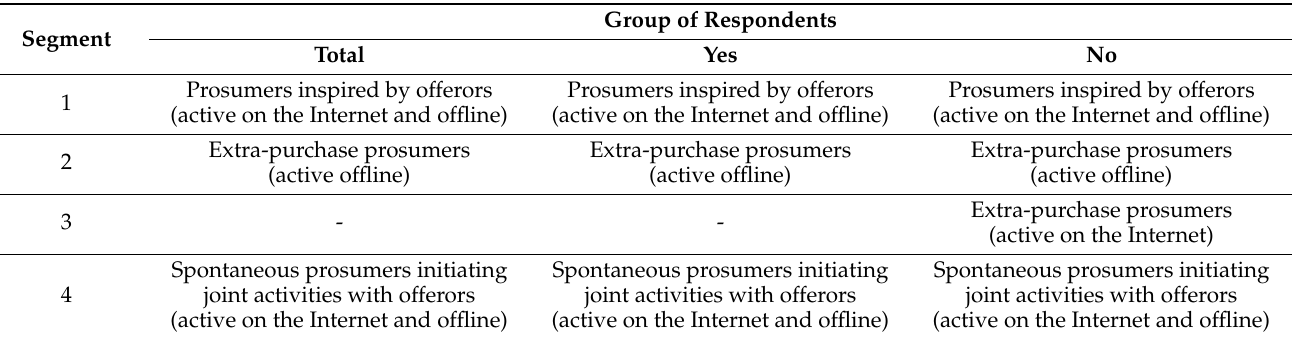
Table 7. Segments of respondents according to total respondents, respondents who positively perceived offerors, and respondents who negatively perceived offerors, based on their prosumer